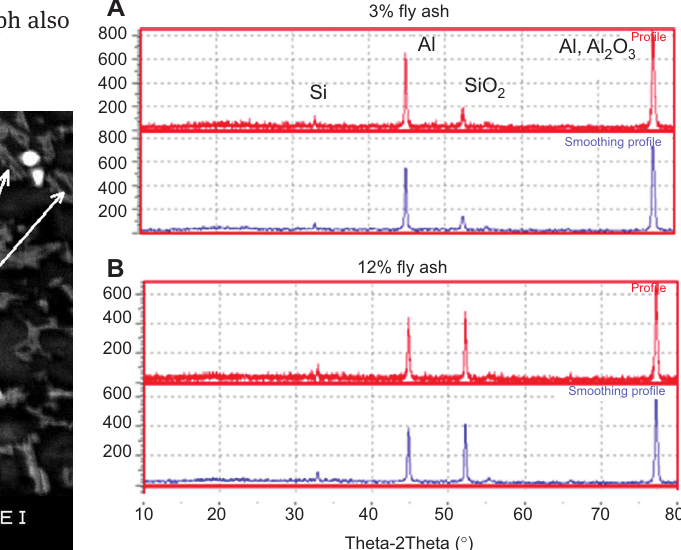
Figure 1 SEM microstructure of composite specimen (75–103 μ m particle size and 6% fly ash).